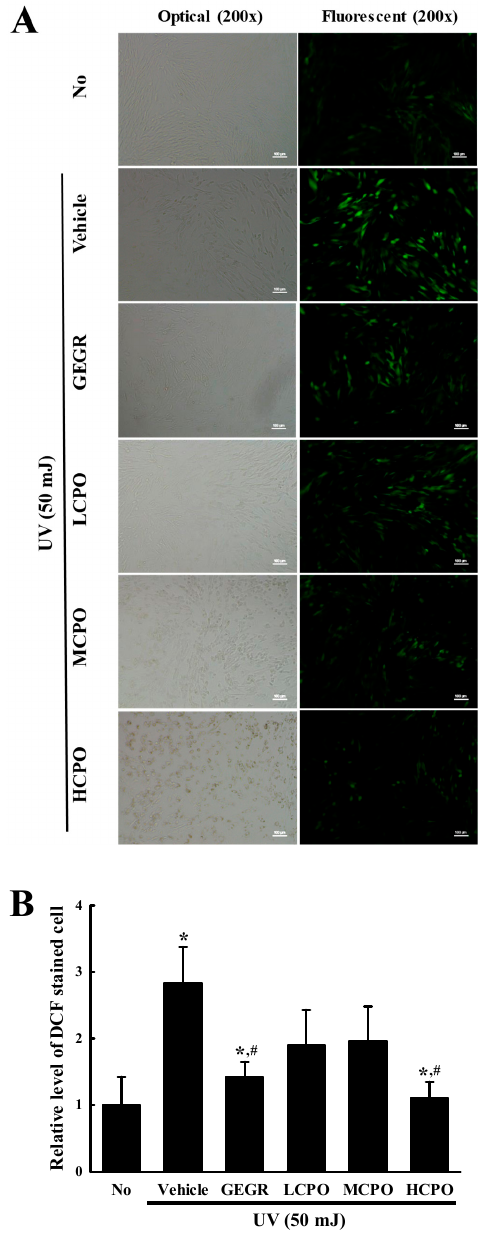
Figure 3. Determination of intracellular ROS